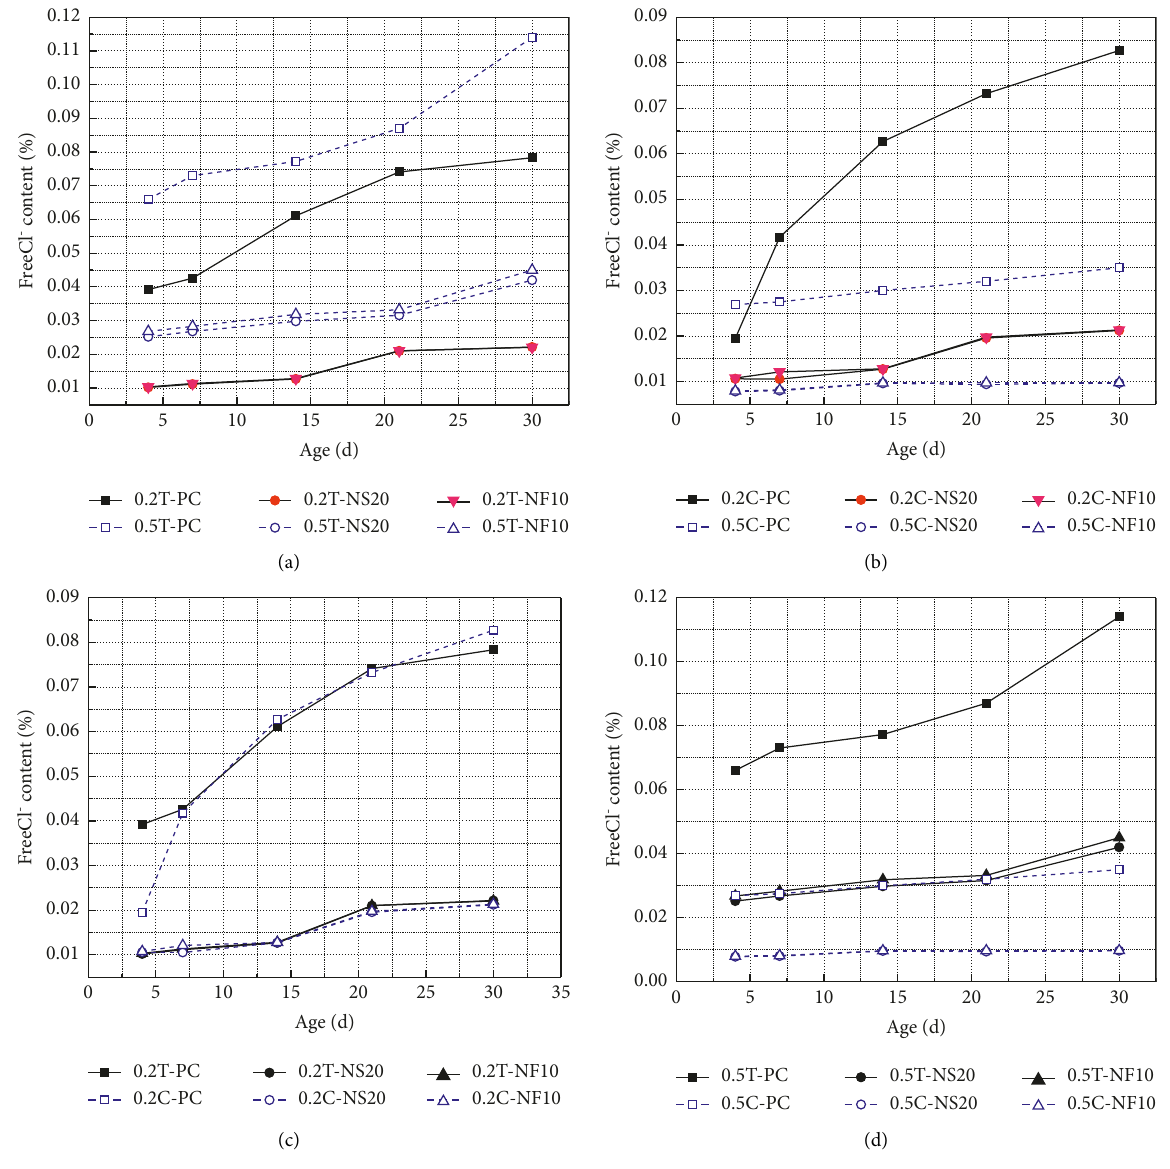
Figure 10: (a) Tensile zone. (b) Compressive zone. (c) Comparison between tensile and compressive zones ( σ � 0.2). (d) Comparison between tensile and compressive zones ( σ �